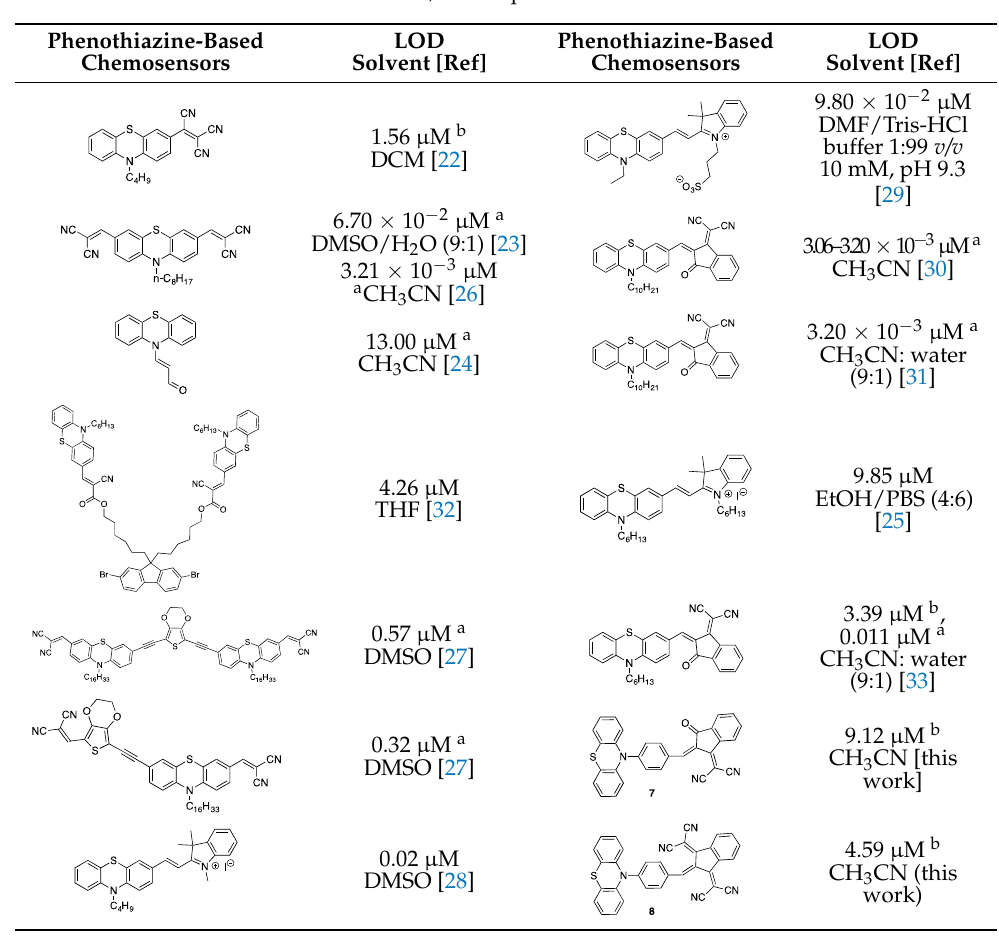
Table 4. Literature survey of optical phenothiazine-based chemosensors used in cyanide sensing associated with their LOD. a Fluorescence, b absorption.